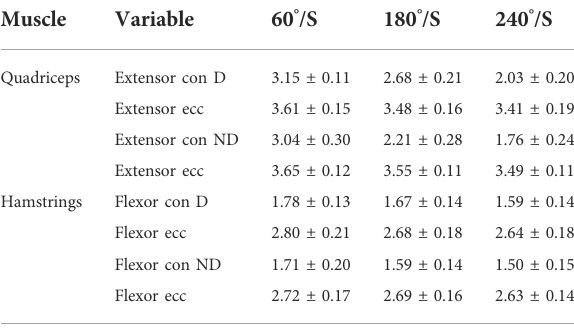
TABLE 2 Quadriceps and hamstring strength on both sides of the limb for the elite group. Muscle